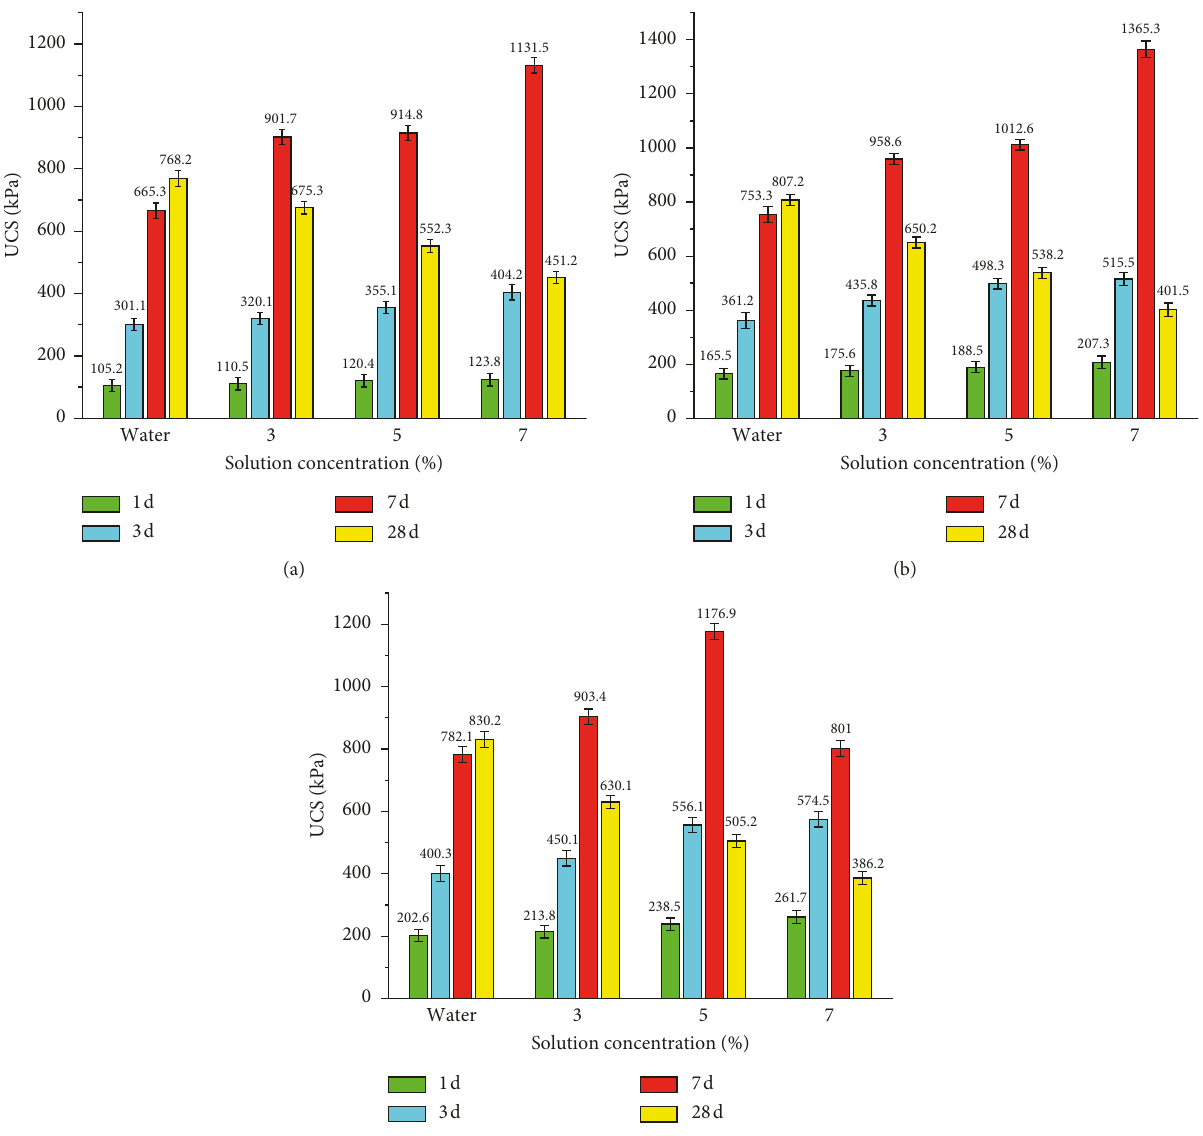
Figure 2: Variation of UCS of CPB under TC coupling conditions. (a) 20 ° C, (b) 35 ° C, and (c) 50 °